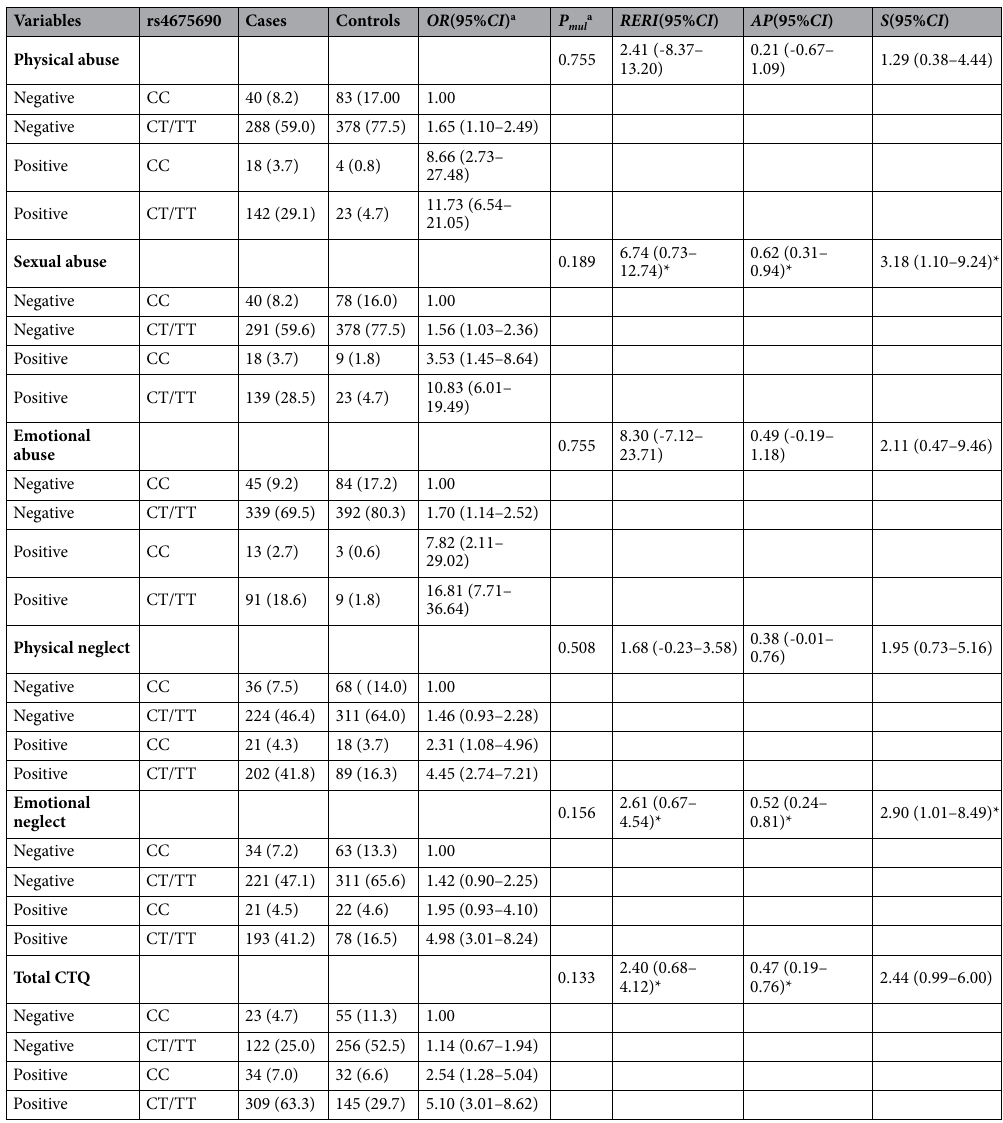
Table 4. Interactions between childhood maltreatment and rs4675690 on the risk of aggression. P mul was calculated using the multiplicative interaction term. a Adjusted by age. *Statistically